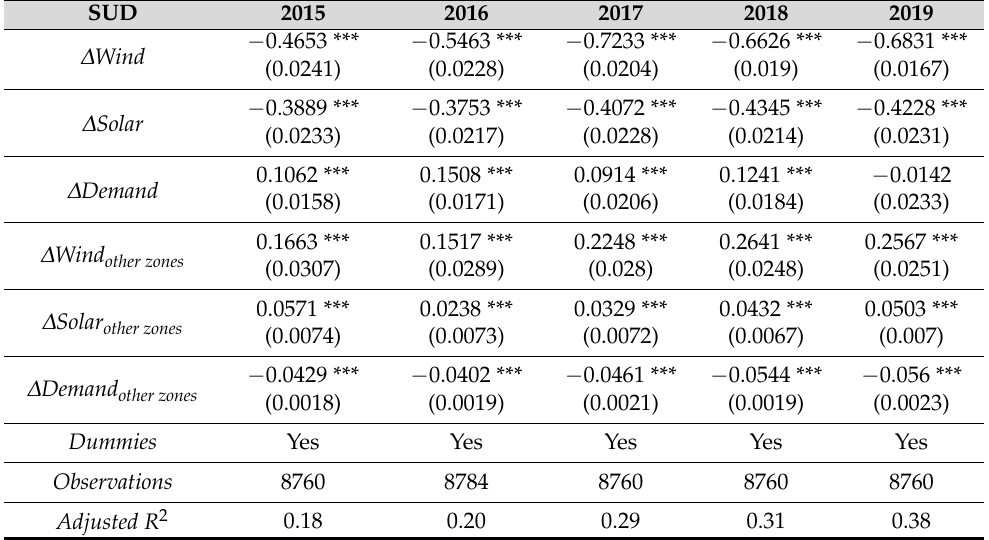
Table A12. OLS estimation of hourly changes in net input flow of SUD; results of Equation